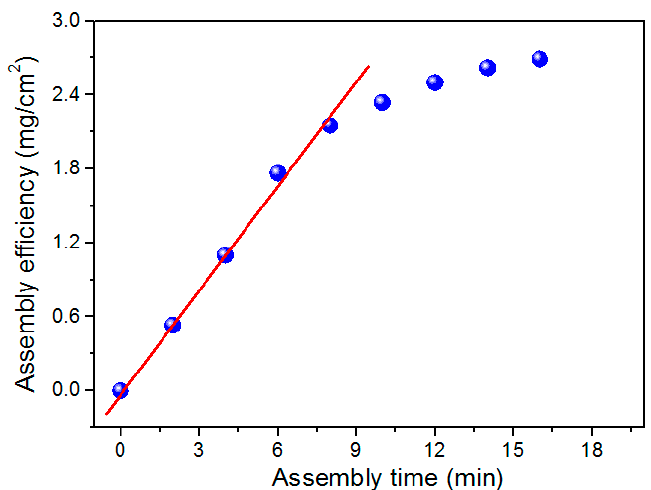
Figure 2. The assembly efficiency as a function of assembly time during the electrophoretic assembly deposition (EAD) process.